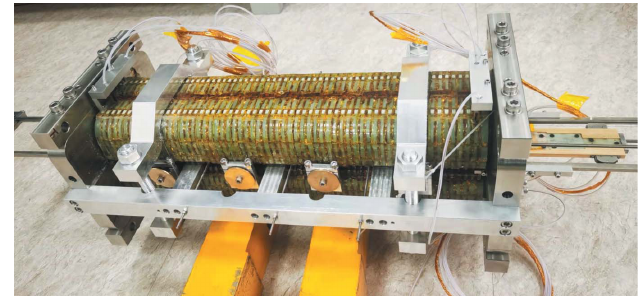
Figure 7 Photograph of the SCU prototype after fabrication.